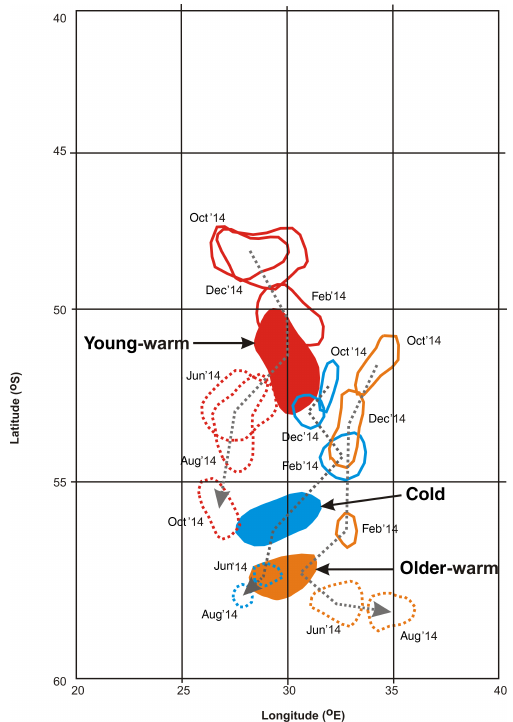
Figure 2. Eddy migration tracks, as inferred from SSHA archive data. Solid red, blue and orange areas respectively reflect the area inside the 10 cm SSHA contour for the young, warm-core, cold- core and the older, warm-core eddies at the time of sampling. Solid red, blue and orange lines, similarly, indicate the position of the eddies (and the extent of the eddy within the 10cm SSHA contour) prior to sampling, at 2-month intervals, as indicated by the labels. Broken red, blue and orange lines indicate the position of the eddies subsequent to sampling, again at 2-month intervals. Black arrows are used to highlight the southerly migration of the